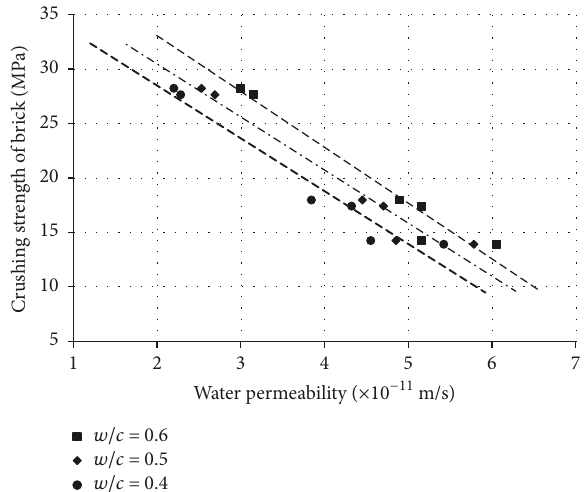
Figure 7: Water permeability with respect to crushing strength of brick.